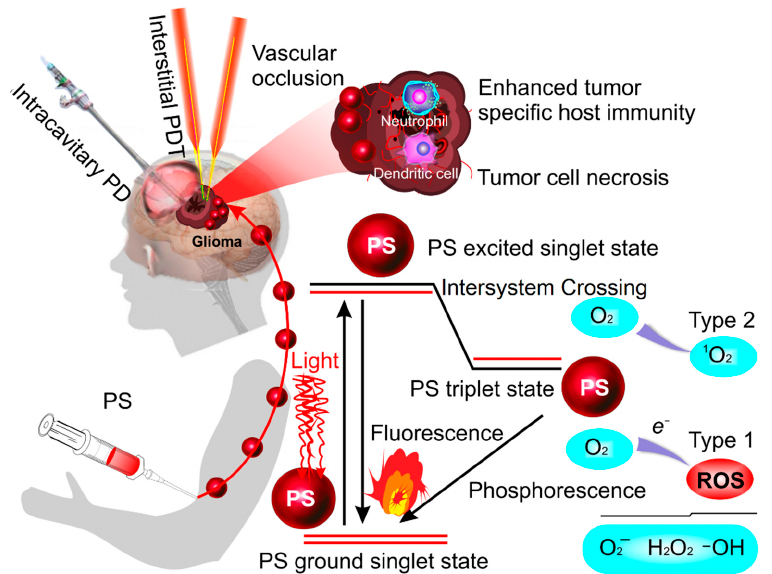
Figure 1. Schematic illustration of intracavitary PDT and interstitial PDT for GBM with an energy diagram of the oxygen response after PS excitation by an appropriate light wavelength. In the singlet state, energy is converted to heat by internal conversion or emitted as fluorescence. Then, PS in the excited singlet state can convert to the excited triplet state. In the triplet state, the energy can un- dergo a Type 1 or Type 2 redox reaction with the generation of the reactive oxygen species (ROS), which induces the death of the GBM cells via necrosis and/or apoptosis. This can also destruct the GBM vasculature and produce an acute inflammatory response that attracts leukocyte activation.